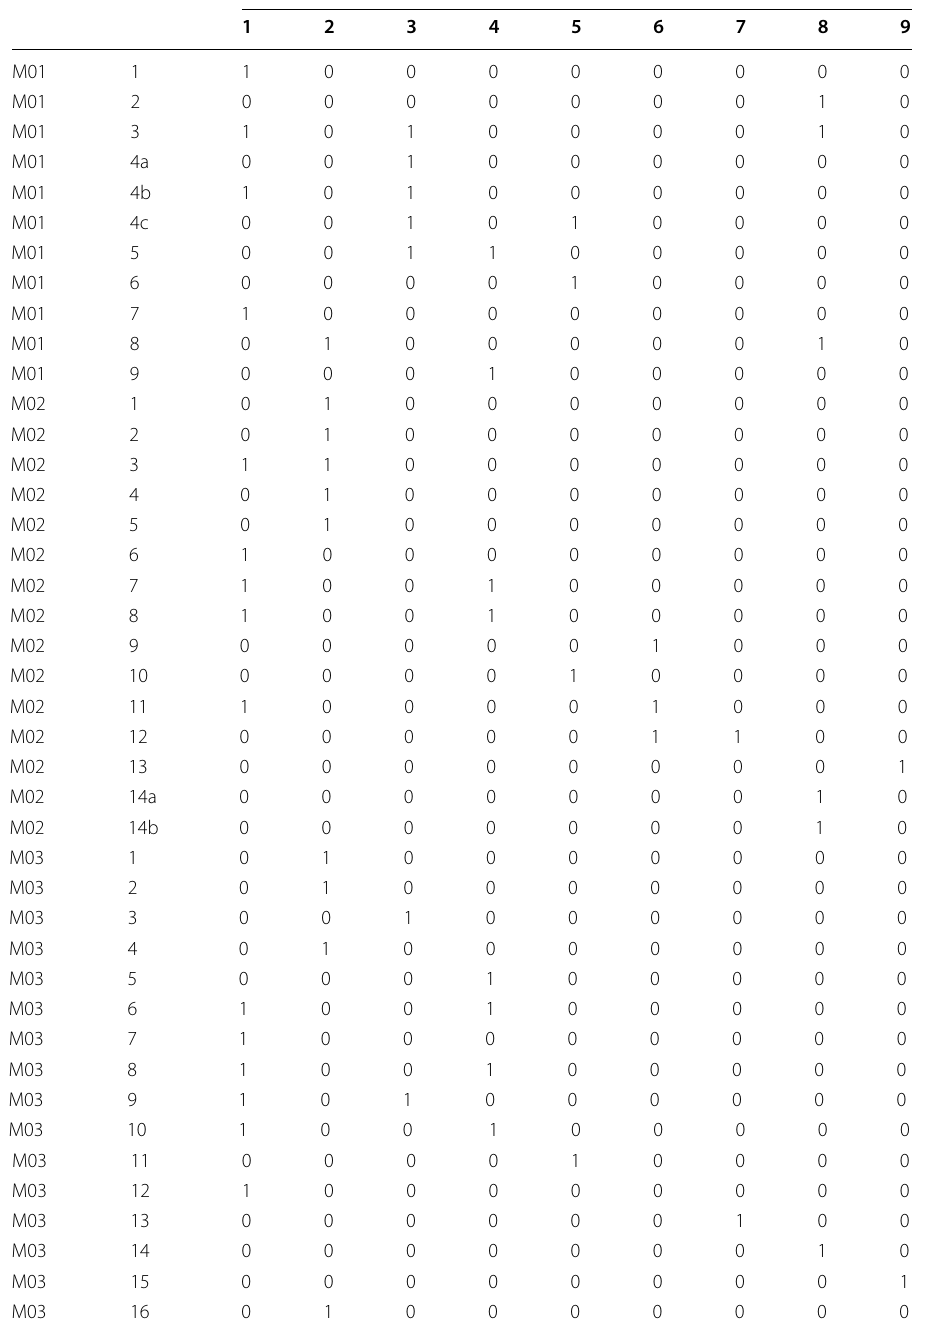
Table 10 Q-matrix refined by the stepwise method: